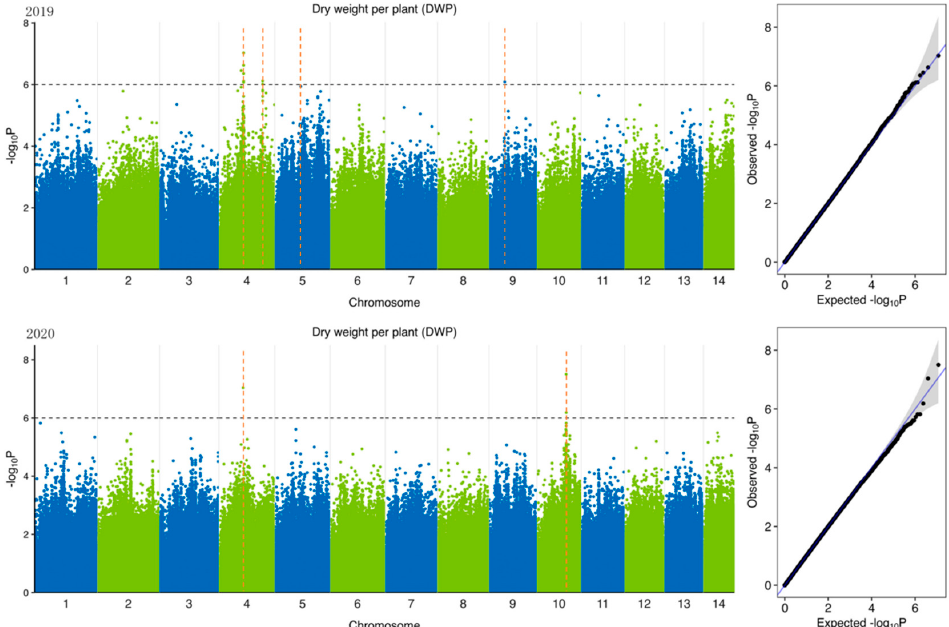
Figure 3. Manhattan plots of GWAS results for dry weight per plant (DWP) in 2019 and 2020. Notes: Blue and green dots represented SNP (single nucleotide polymorphism) sites on chromosomes, respectively. When the value of − log 10 p was above 6 (gray line), the selected SNP site with significant aboriginality. Orange dotted lines represented the location of SNP loci.